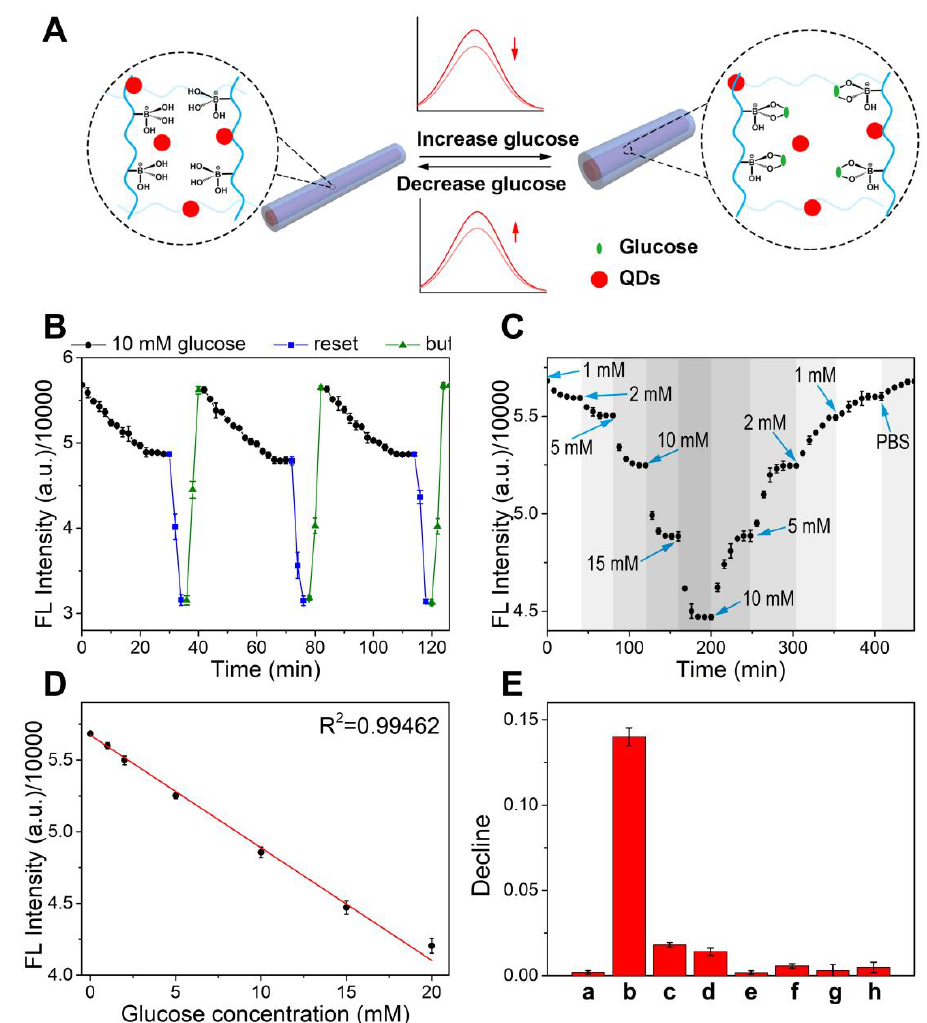
Figure 5. ( A ) Schematic diagram of volume change of the hydrogel and the fluorescence change caused by glucose concentration changes. ( B ) Time response of the sensor for going through three consecutive glucose additions, buffering, and sensor resetting cycles. The dots represent the fluorescence intensity recorded every 2 min. ( C ) Time response of the sensor for continuous glucose monitoring. The dots represent the fluorescence intensity recorded every 8 min. The moments when pH start to change are pointed out with arrows. ( D ) Linear detection for glucose of the sensor. ( E ) Percentage of fluorescence intensity decline; a–h: blank hydrogel, glucose, lactate (0.75 mM), fructose (8.1 µ M), K + , Na + , Mg 2+ , Ca 2+ . Error bars in ( B – E ) are based on standard deviations (n = 3).